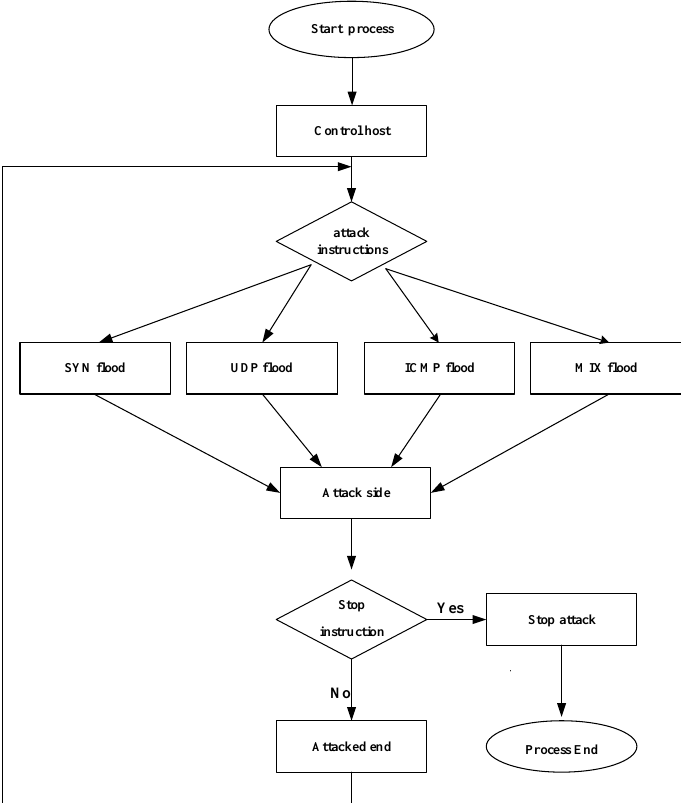
Figure 14. The procedure of DDoS attack.